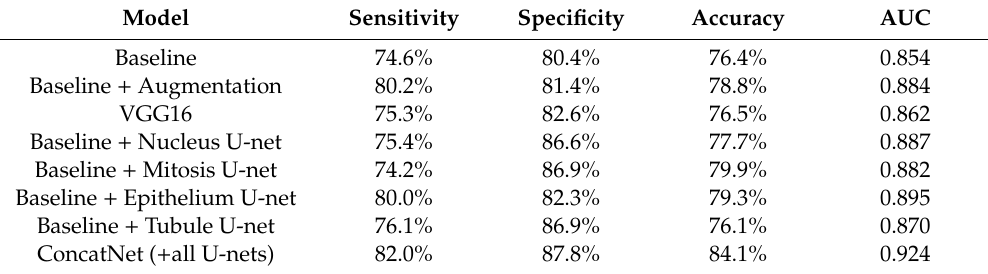
Figure 2. Receiver Operating Characteristic (ROC) curves for all models evaluated on the test set. Dotted line indicates AUC = 0.5. Table 3. Results on the test set for models evaluated.